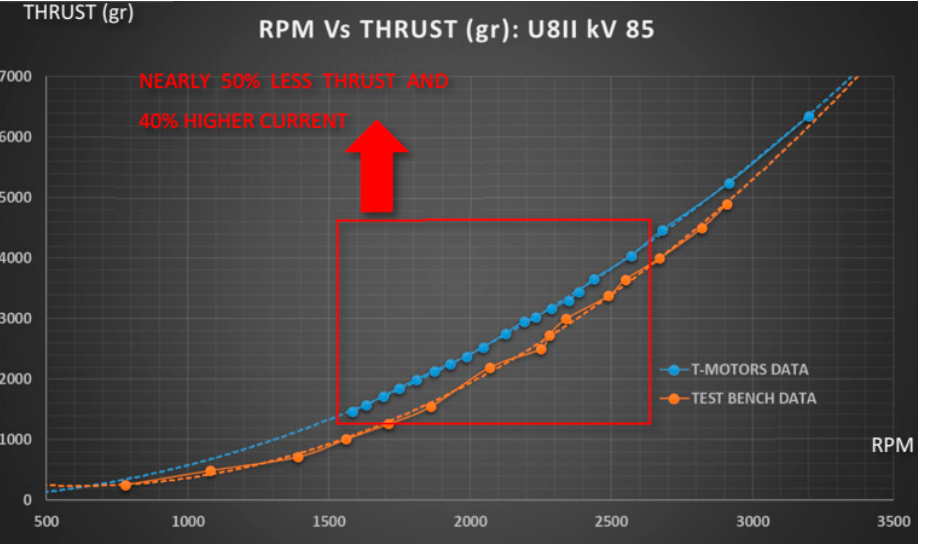
Figure 1. Comparison between product specifications and measured data for a U8II kV 85.